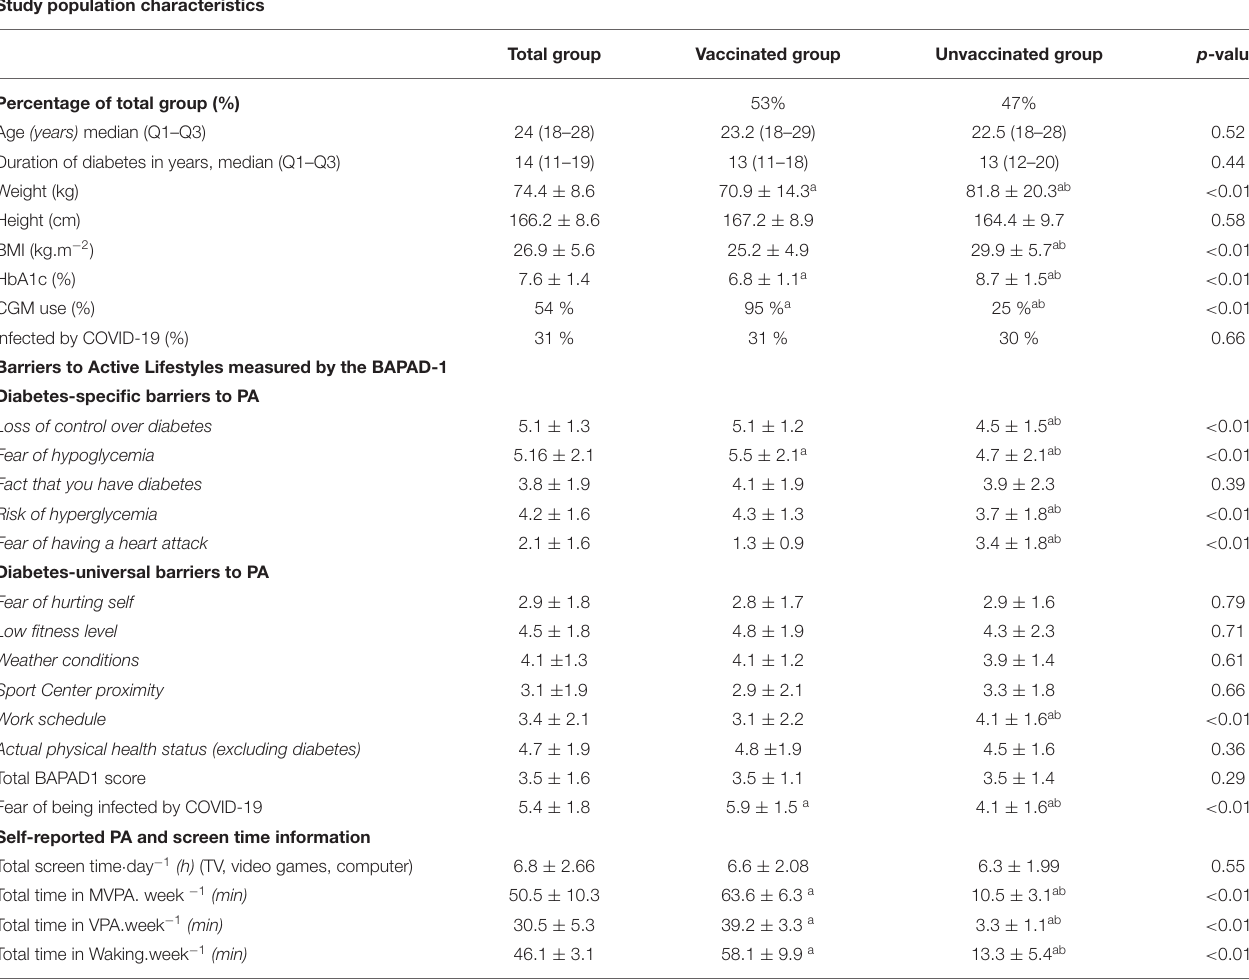
TABLE 1 | Descriptive characteristics and activity profile of Qatari adults with type 1 diabetes during. Study population characteristics